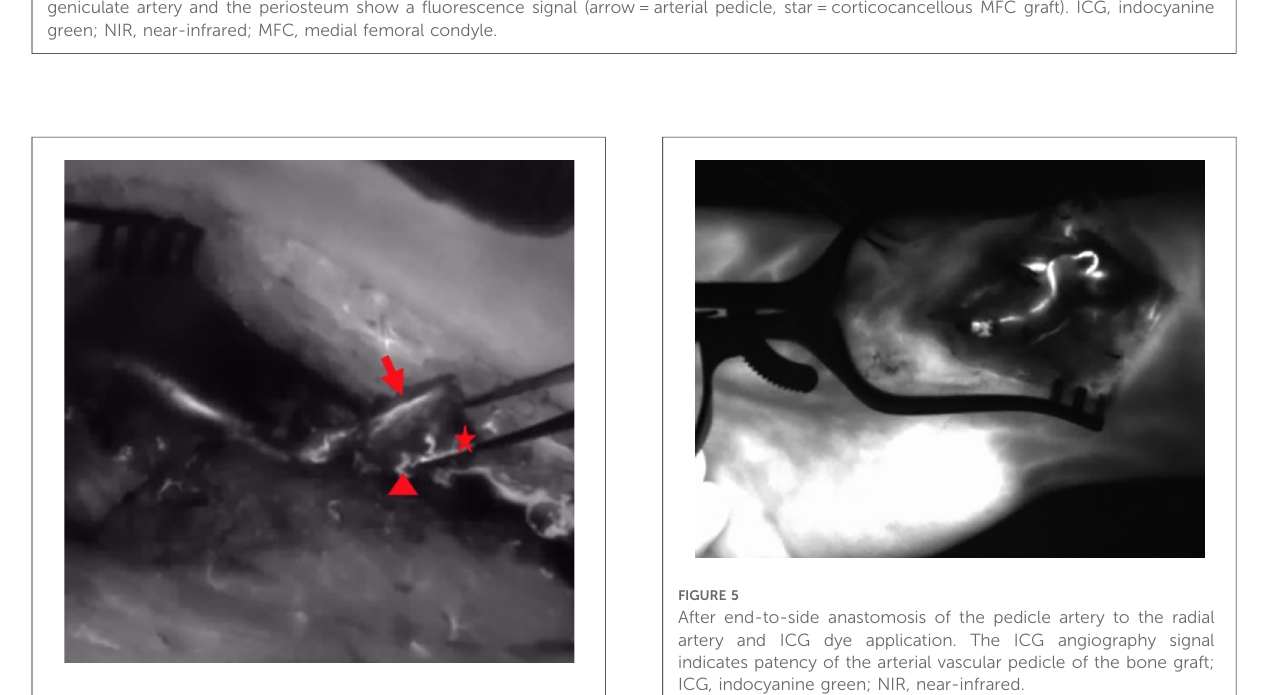
FIGURE 4 After ICG dye injection, NIR perfusion of the periosteum and the osteotomy site and cut edge (arrow=periosteum, star= osteotomy site, triangle=nutrient vessel at the osteotomy site); ICG, indocyanine green; NIR, near-infrared.